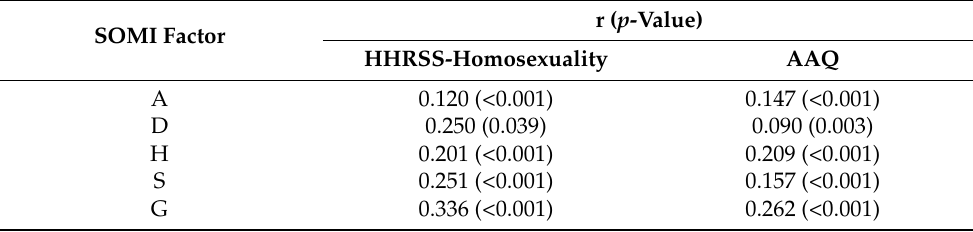
Table 5. Concurrent validity of the Sexual Orientation Microaggression Inventory (SOMI) with HIV and Homosexuality Related Stigma (HHRSS), and Acceptance and Action Questionnaire-II